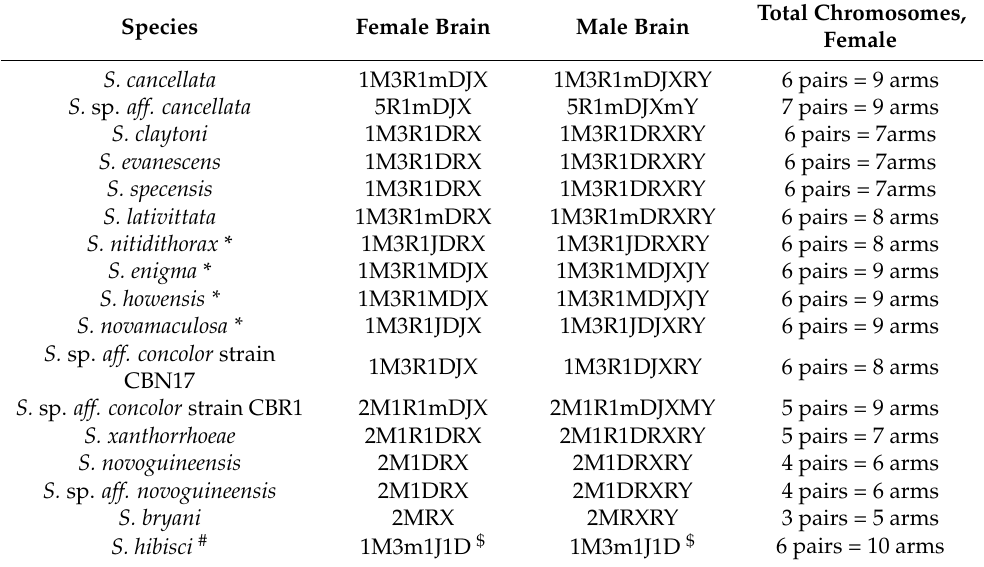
Table 3. Karyotypes of the species (M = large metacentric; m = small metacentric; J = submetacentric; R = rod or acrocentric; D = dot) * from Bock [11], and # from Wilson et al.